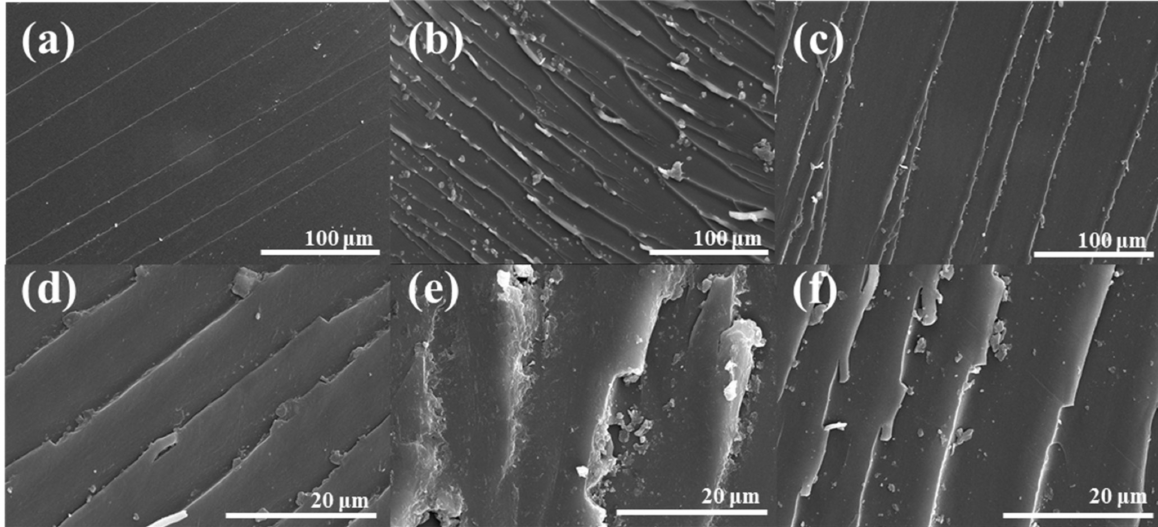
Figure 7. Fracture surface of the DGEBA/PEI blends: ( a , d ) neat DGEBA, ( b , e ) 2wt % of PEI, and ( c , f ) 4 wt% of